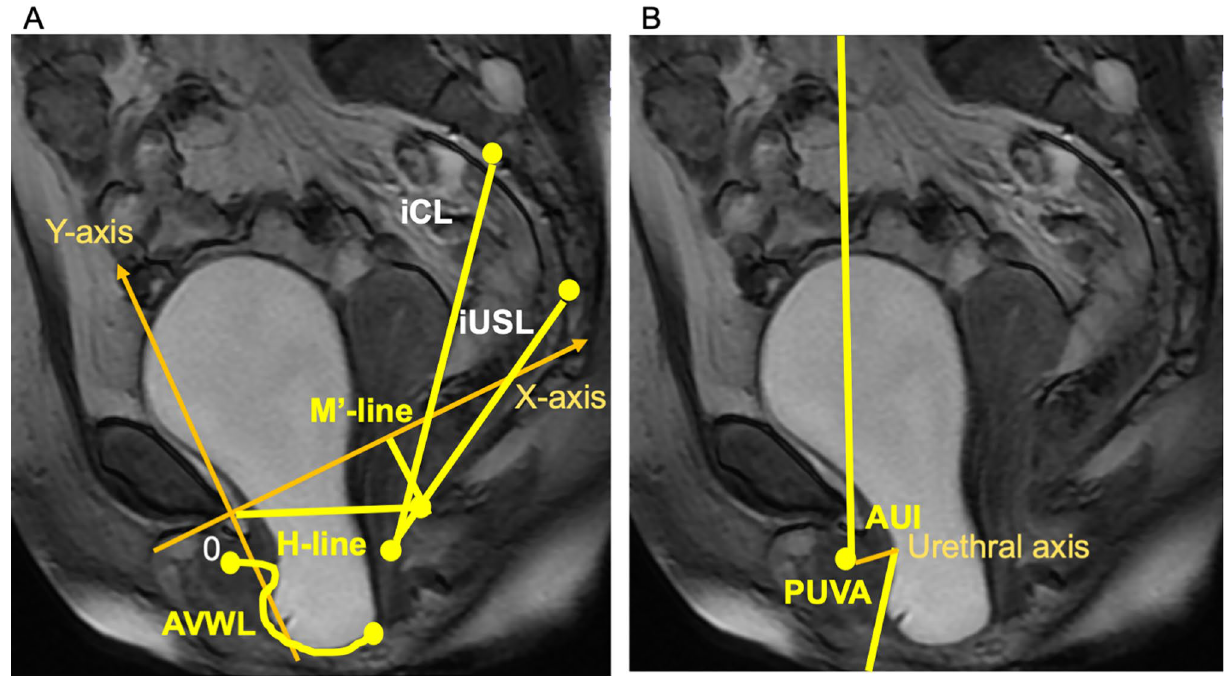
Figure 4. Methods to calculate parameters of pelvic organ support and bladder outlet obstruction on dynamic magnetic resonance imaging. ( A ) Shows measured parameters as follows: the anterior vaginal wall length (AVWL) is traced from the anterior vaginal fornix to the external urinary meatus; the length of the urogenital hiatus (H-line) is traced from origin to anorectal angle; the imaginary cardinal ligament (iCL) is traced from the anterior surface between the second and third sacral bones to the uterine cervix (C); the imaginary uterosacral ligament (iUSL) is traced from the anterior surface between the fourth and fifth sacral bones to C; the hiatal descent (M ′ -line) extends perpendicularly from the SCIPP line to the posterior end of the H-line. ( B ) Shows measured parameters for bladder outlet obstruction: the angle of urethral inclination (AUI) is the angle of the urethral axis in relation to the vertical plane; the posterior urethrovesical angle (PUVA) is the angle between the urethral axis and the posterior border of the bladder base or